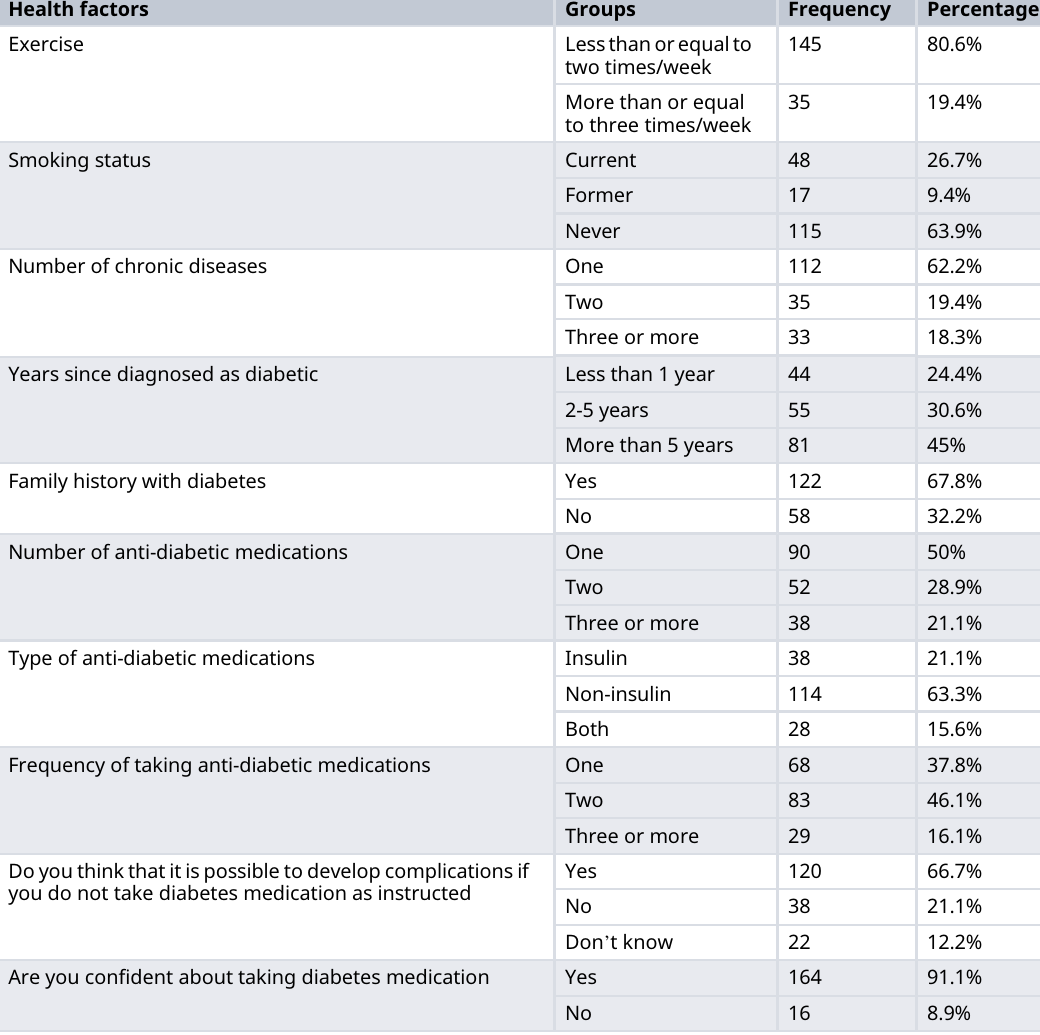
Table 2. Number and percentage of the questions on health information